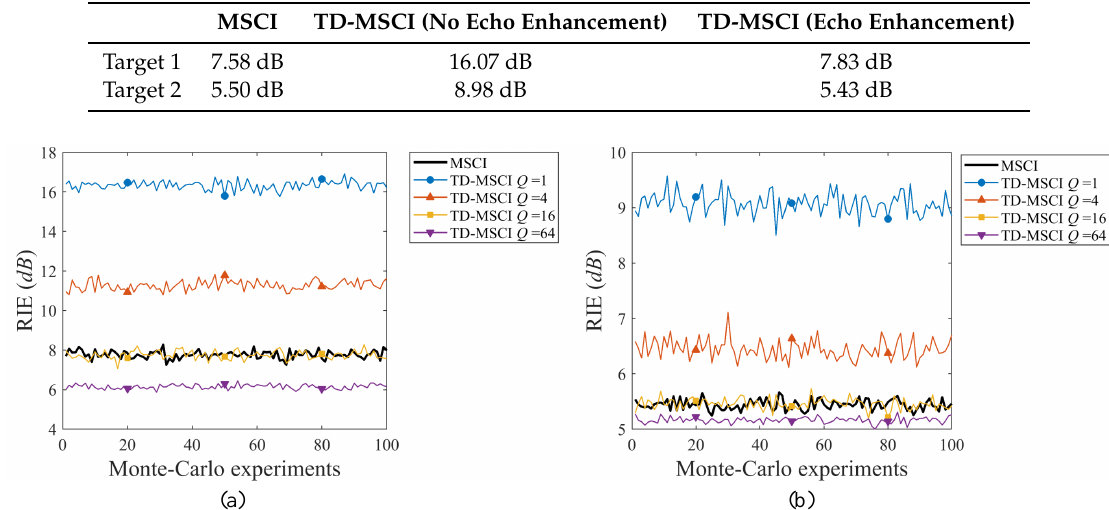
Figure 7. RIE comparison of conventional MSCI and TD-MSCI in 100 times Monte-Carlo experiment. ( a ) is the result of target 1. ( b ) is result of target 2. Q is the coherent integration